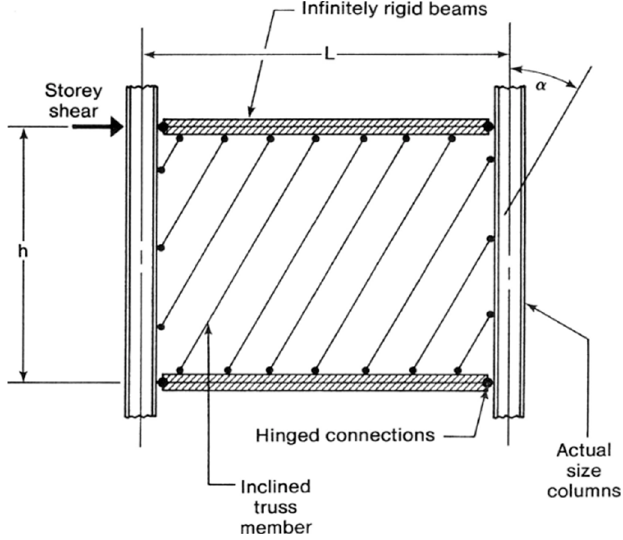
Figure 1. The strip model by Thorburn et al. [20] .